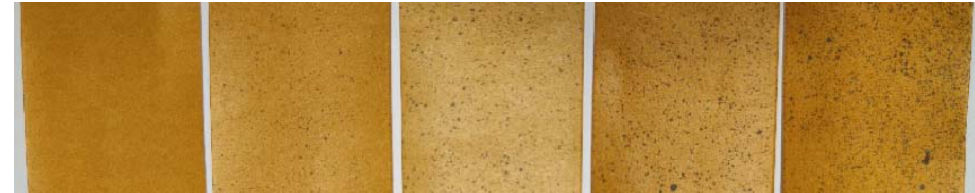
Figure 12. Fog droplet adhesion grade.